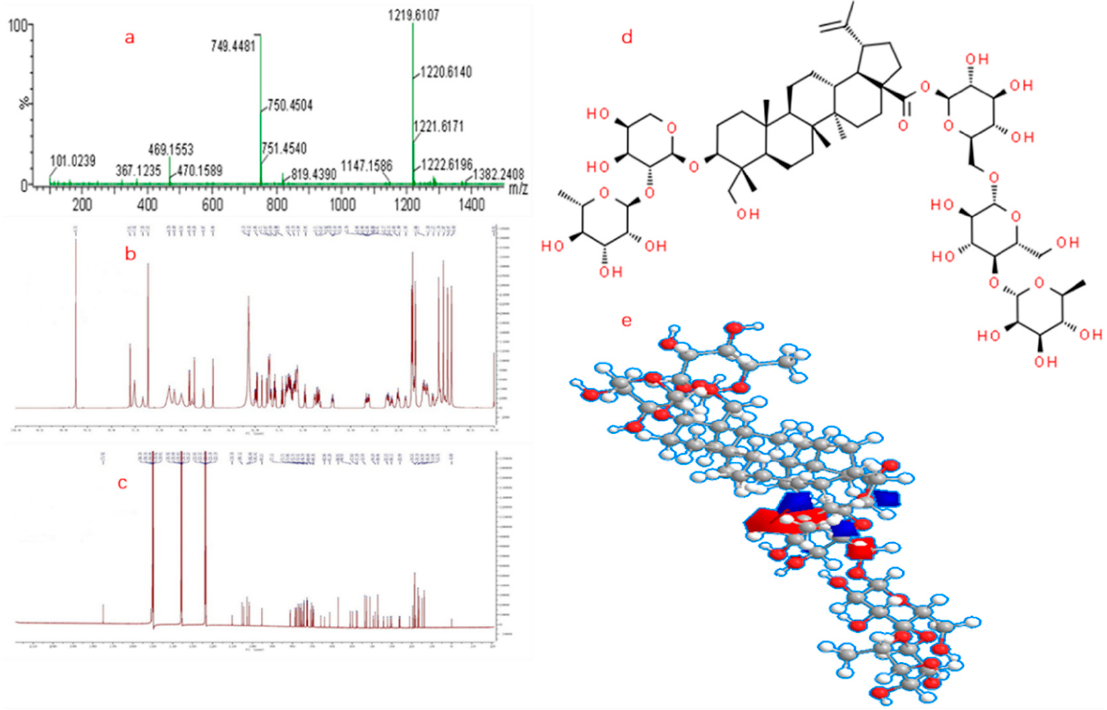
Figure 2. Molecular structure confirmation of P-b4: ( a ) MS spectra of P-b4; ( b ) 1 H-NMR of P-b4; ( c ) 13 C-NMR of P-b4; ( d ) 2D molecular structure of P-b4; ( e ) 3D molecular structure of P-b4.